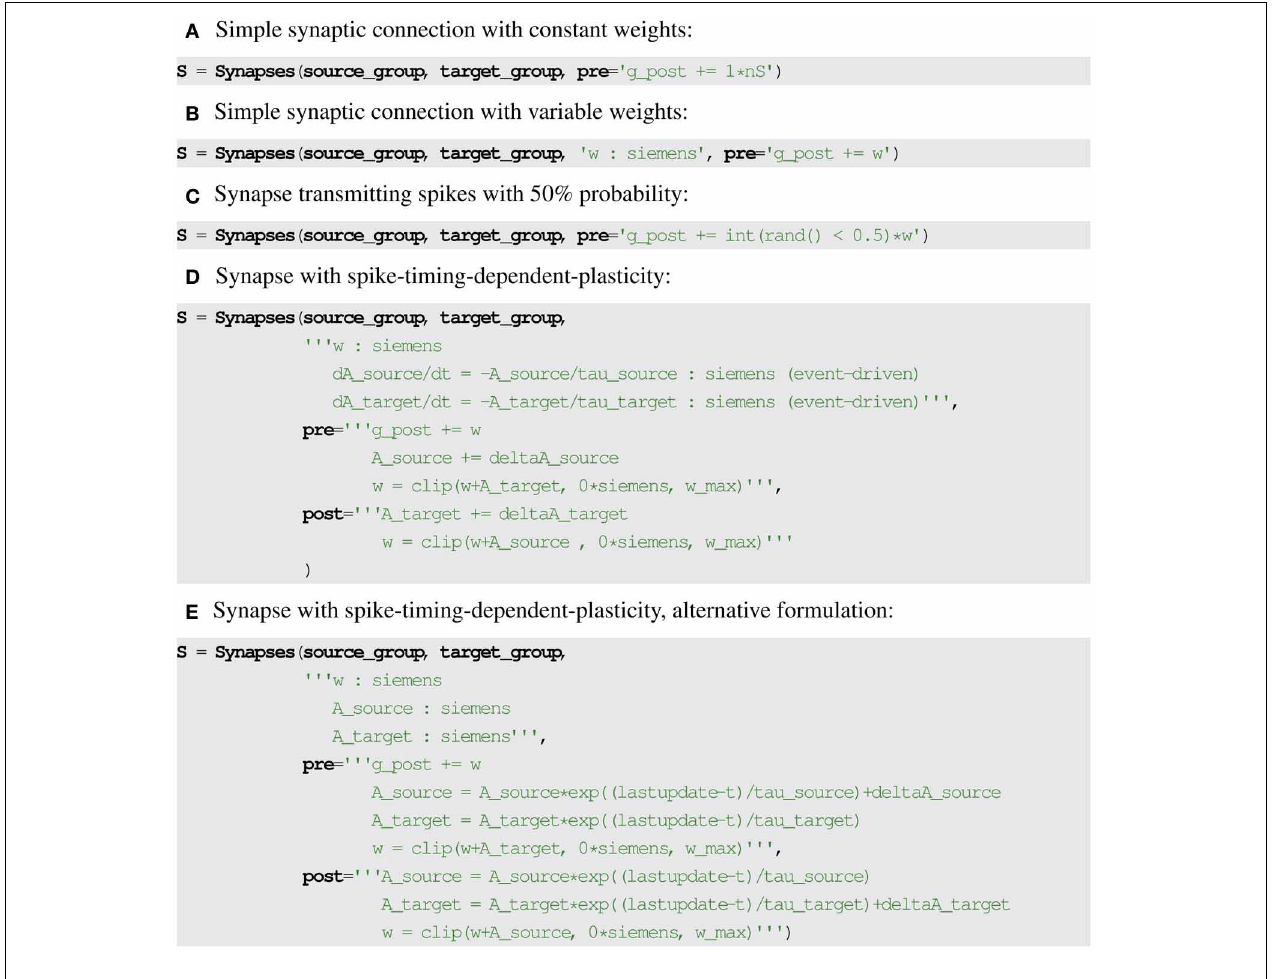
FIGURE 3 | Examples for synaptic model descriptions in Brian2. (A–C) Forward propagation is described by specifying statements to be executed on the arrival of a pre-synaptic spike (keyword argument pre ), changing the value of post-synaptic variables (suffix _post ). (D,E) Equivalent definitions of spike timing-dependent plasticity using forward and backward propagation.